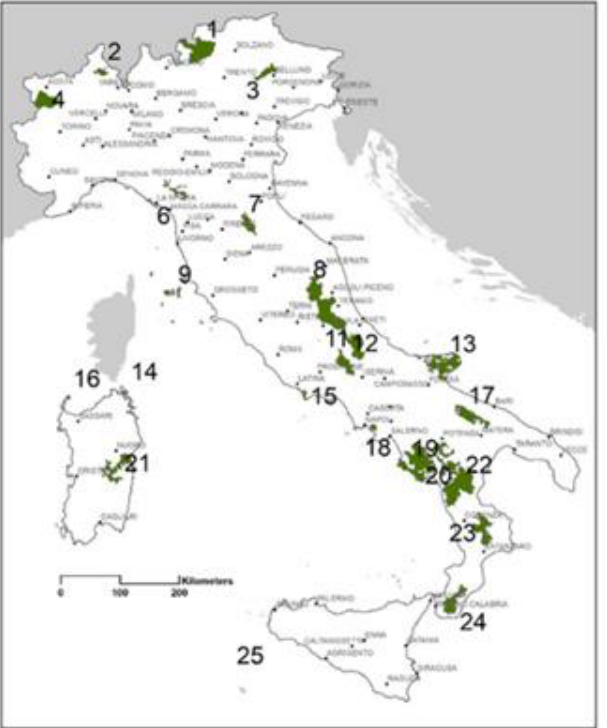
Figure 1. Italian NPs: geographic location (source: http://www.parks.it, accesses on 1 January